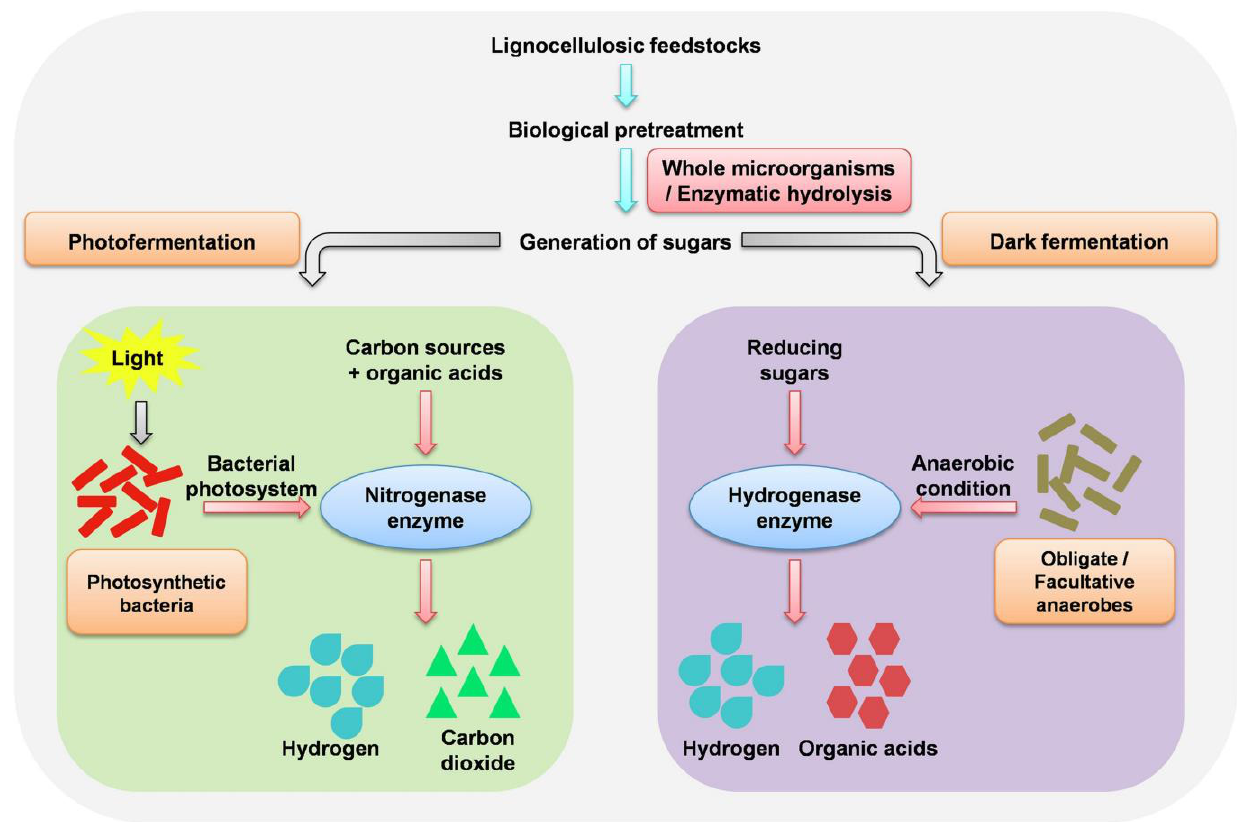
Figure 3. Photo-fermentation and dark fermentation processes (reproduced from [57], published under CCBY 4.0 license).